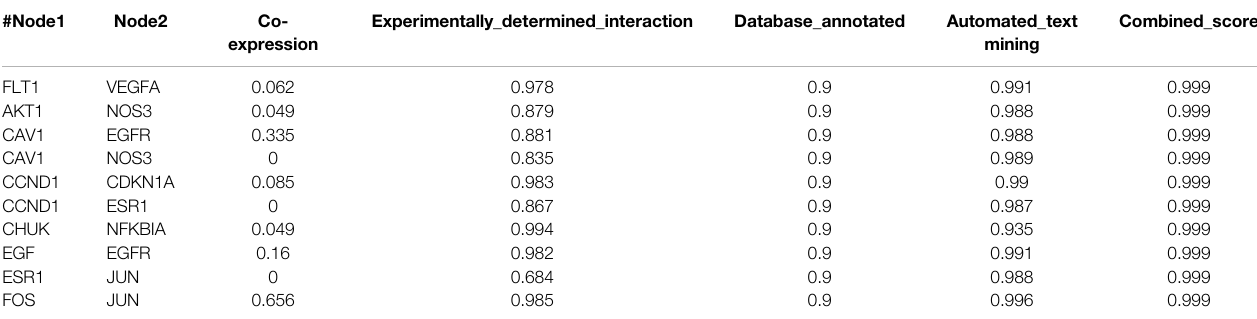
TABLE 4 | | PPI network